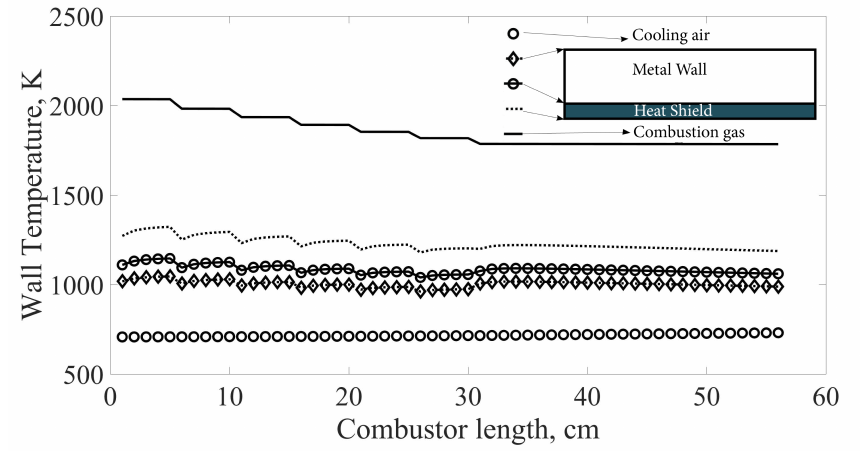
Figure 7. Temperature variation at various points across the conventional combustion chamber